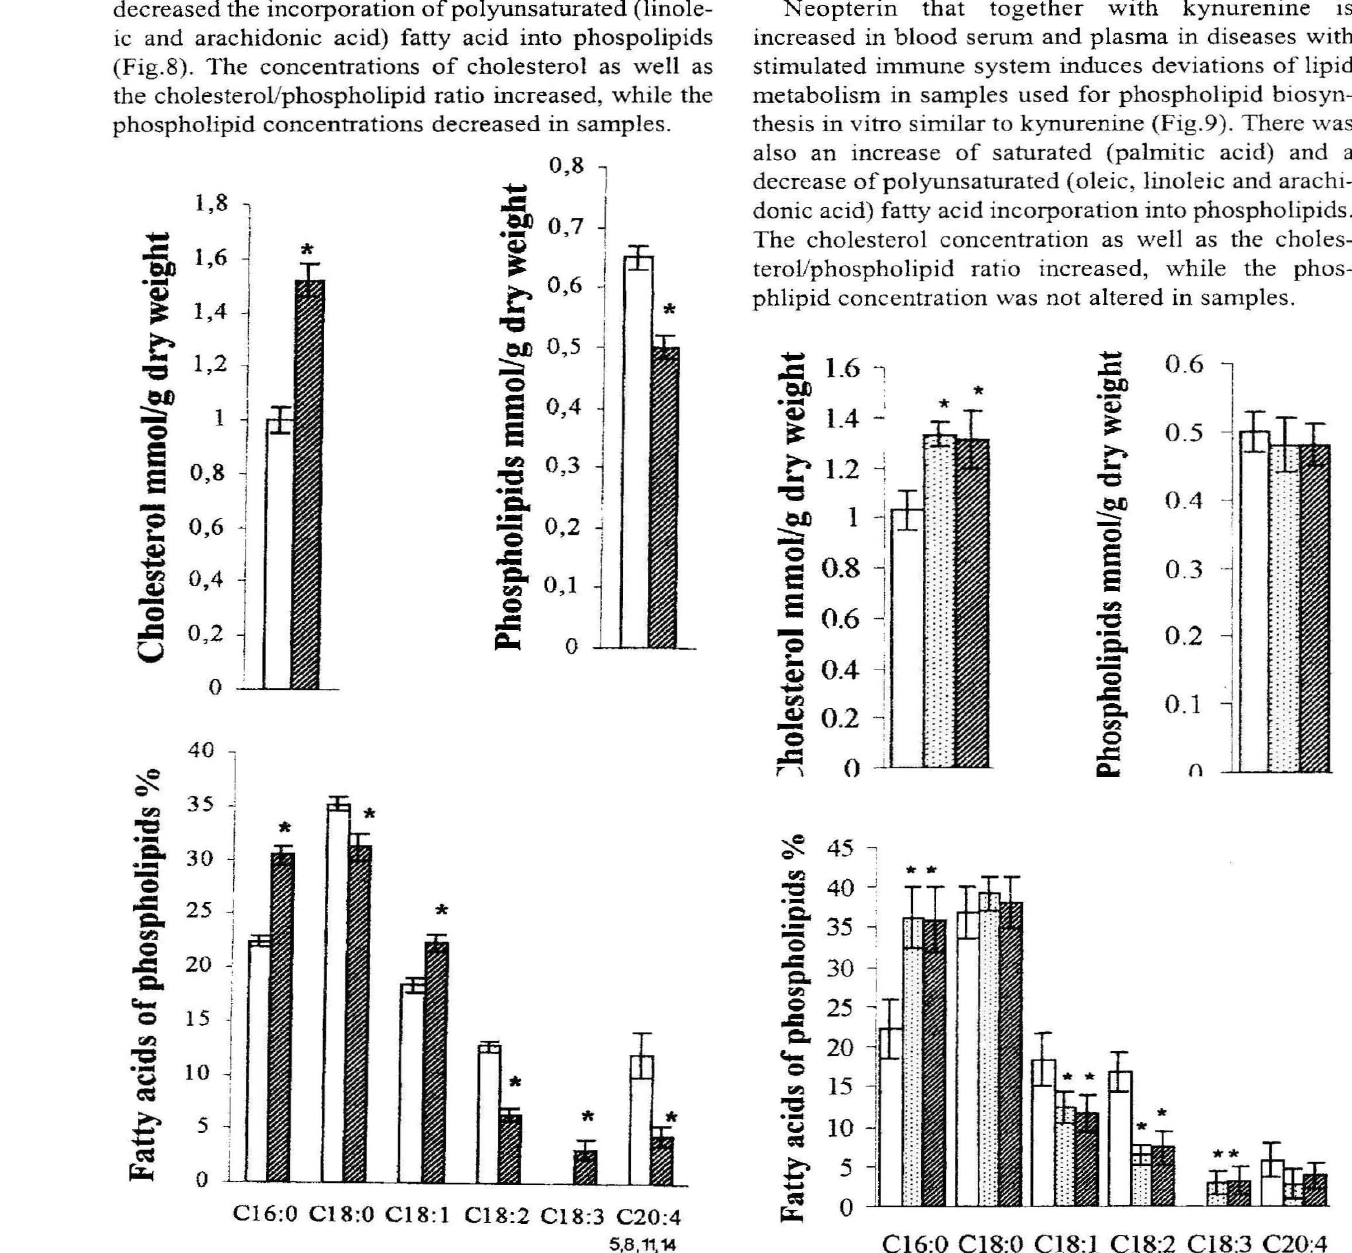
Fig.9. Concentrations (mean ± SO) of cholesterol and phospholipids, as well as fatty acid content in per cent (mean ± SD) of phospholipids in control samples (open bars) and in samples with 5 pmol/g wet weight neopterin (dotted bars) ar with 30 pmol/g wet weight neopterin (hatched bars). Samples of rat liver tissue homogenate were used for phospholipid biosynthesis in vitro. Incubation medium : Krebs-Ringer-phosphate buffer (pH=7.4) containing 0.3% albumin, fatty acid mixture and glycerol. Samples were incubated